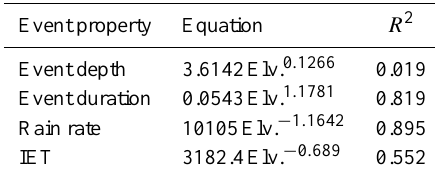
Table 5. Regression equations that relate median of rain event prop- erties (MIT=8h) to terrain